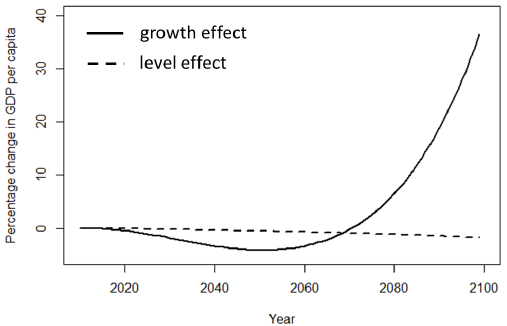
Figure 3. Percentage change in average world GDP per capita for a global cooling of 4 ◦ C in 2100 as projected from nonlinear effects of temperature on GDP level (dashed line; Newell et al., 2018, spec- ification) or growth (plain line; Burke et al., 2015, specification). Reference GDP path according to the SSP5